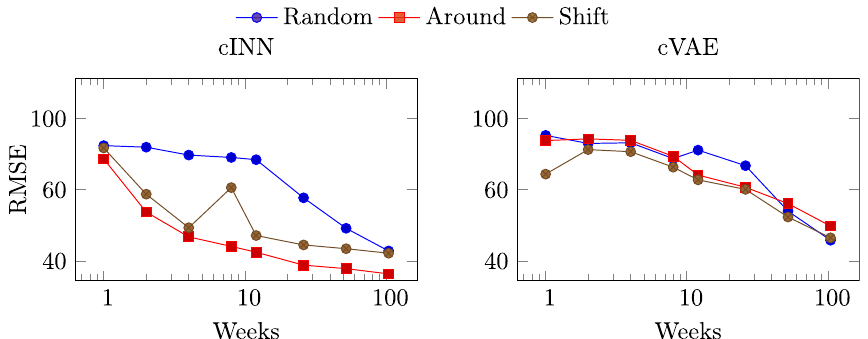
Fig. 5 The RMSE of the three seed noise sampling strategies and two generative models given different amounts of available target data ( MT_124 ). The used forecasting model is the FCN and the LSFE is applied with the combined data combination